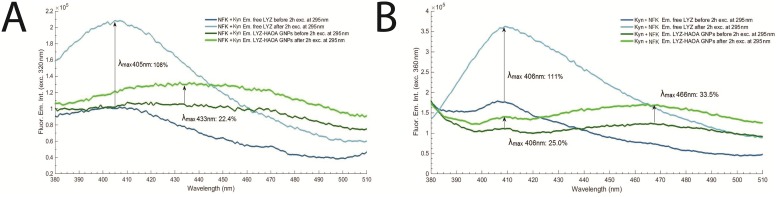

A) Fluorescence emission spectra for NFK + Kyn, before and after excitation of free LYZ and LYZ-conjugated HAOA gold nanoparticles (GNPs), at a fixed wavelength of 320 nm. Experiments were conducted at 20°C and excitation slit size fixed at 2.0 mm (4.4 μW); B) Fluorescence emission spectra for Kyn + NFK, before and after excitation of free LYZ and LYZ-conjugated HAOA gold nanoparticles (GNPs), at a fixed wavelength of 360 nm. Experiments were conducted at 20°C and excitation slit size fixed at 2.0 mm (4.4 μW).